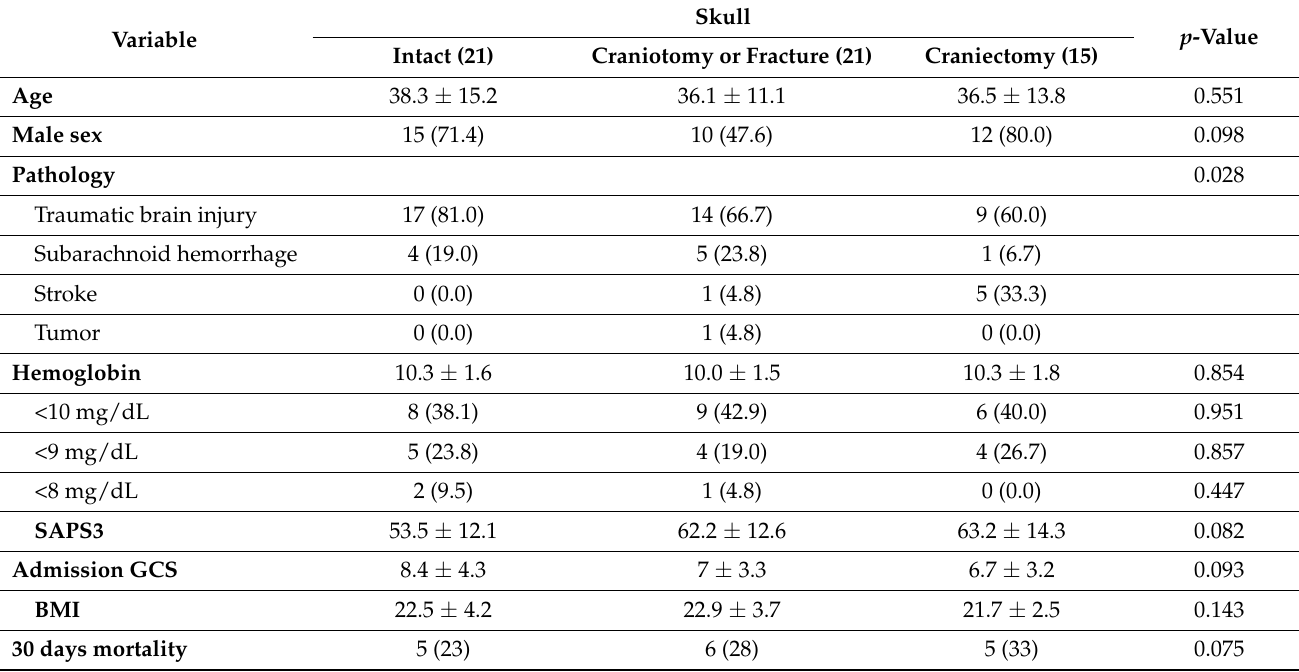
Table 1. Sample characteristics according to skull defect ( n = 57).